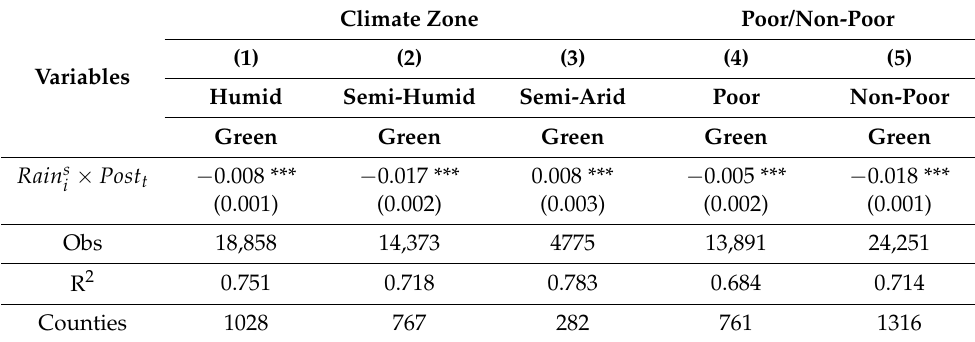
Table 7. Heterogeneity analysis 1: Climate and